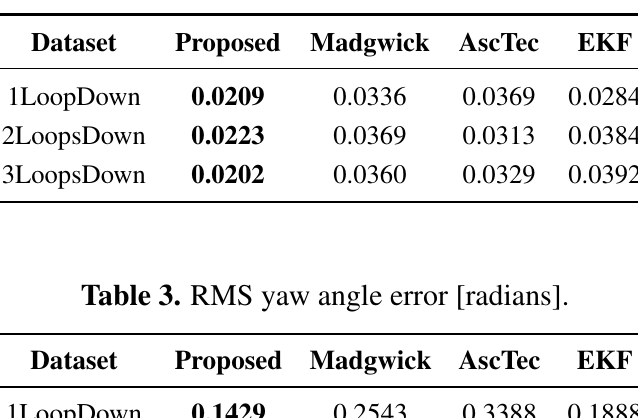
Table 2. RMS pitch angle error [radians].